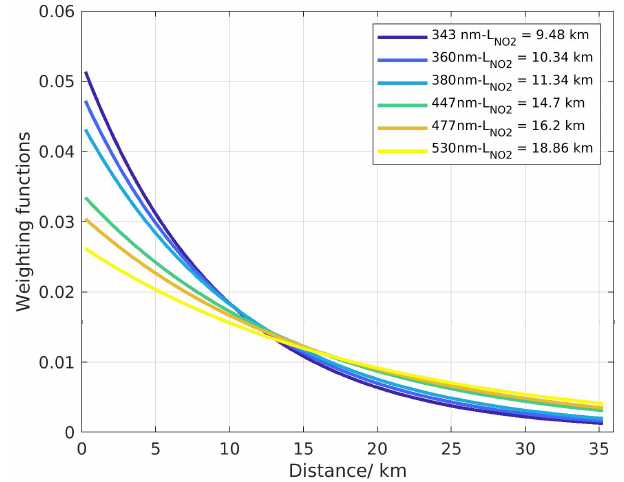
Figure 11. Examples of weighting functions used in the new horizontal distribution inversion approach (11 September 2018,